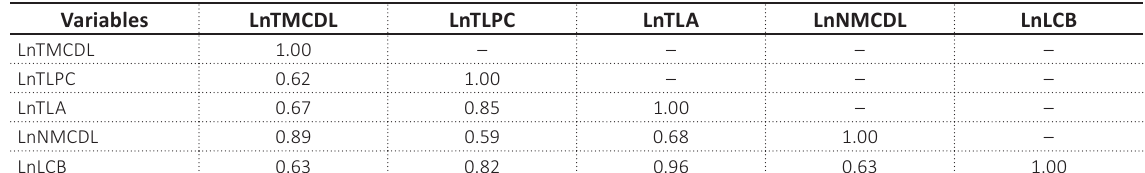
Table 2. Measurement of associations